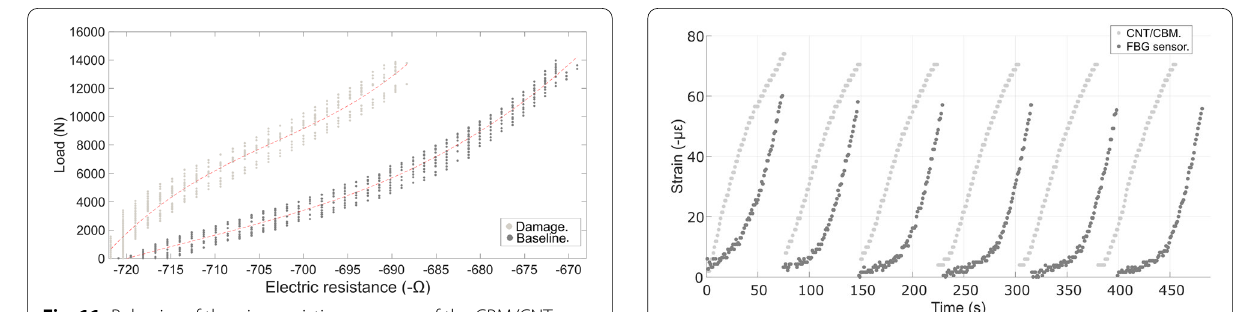
Fig. 12 Behavior of the CBM/CNT and the FBG sensor as a function of time. Dynamic load from 0 to 15 kN.